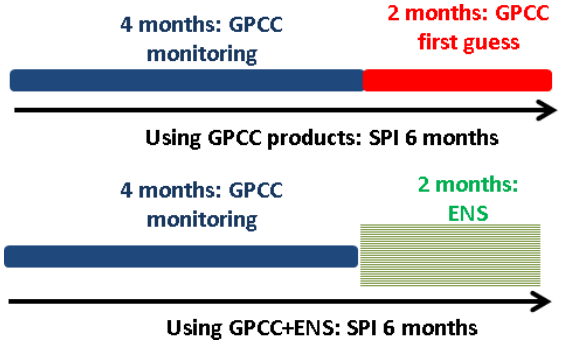
Figure 3. Schematic of the SPI 6 calculation in near-real time using GPCC monitoring and first guess products (top) and GPCC moni- toring and ENS (bottom).